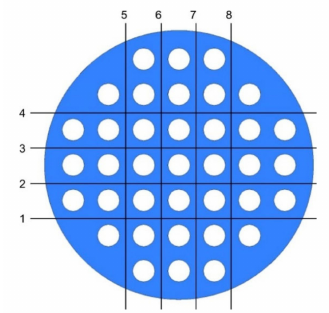
Figure 13. Location of lines applied for data extraction for purposes of determining velocity profiles.